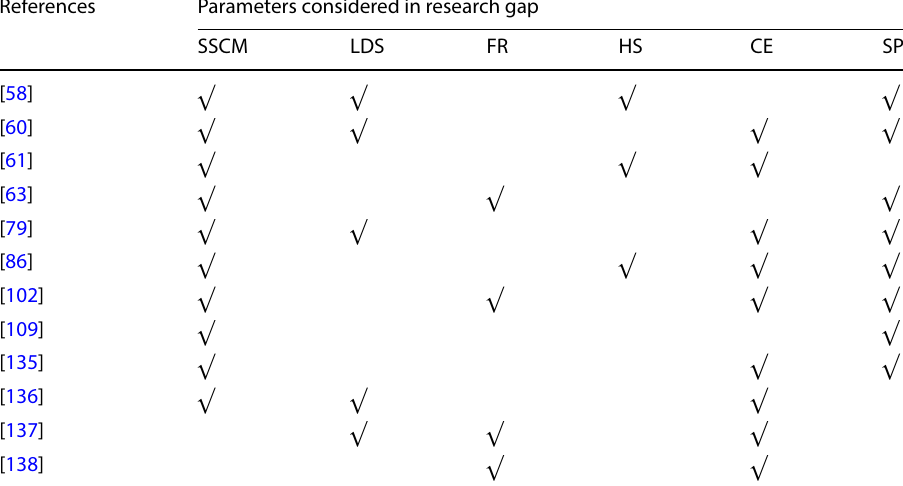
Table 7 Summary of comparison between the current and existing